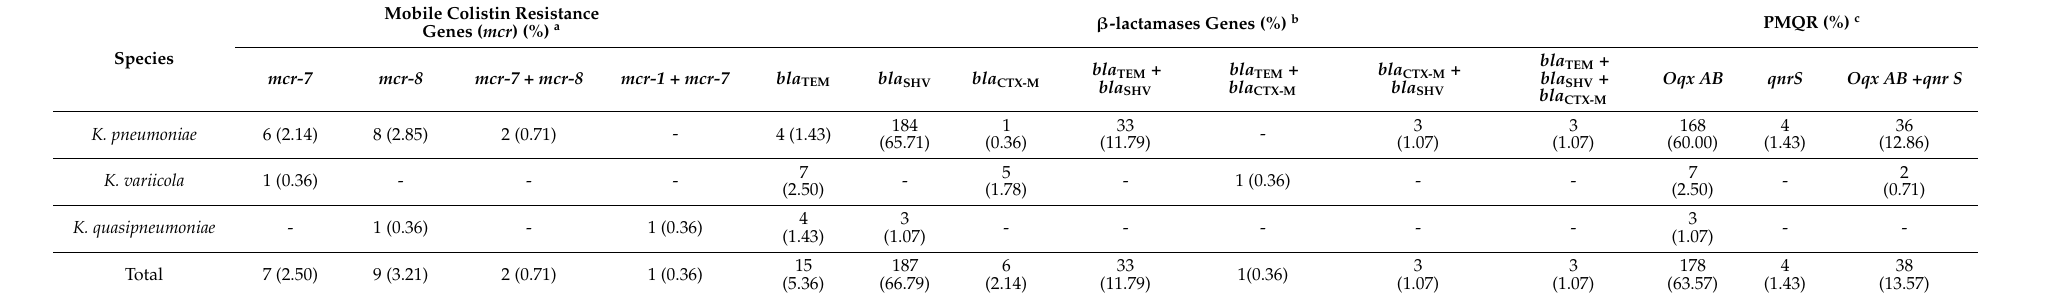
Table 1. Profiles of antimicrobial resistance genes found in KpnC isolates from slaughtered pigs in